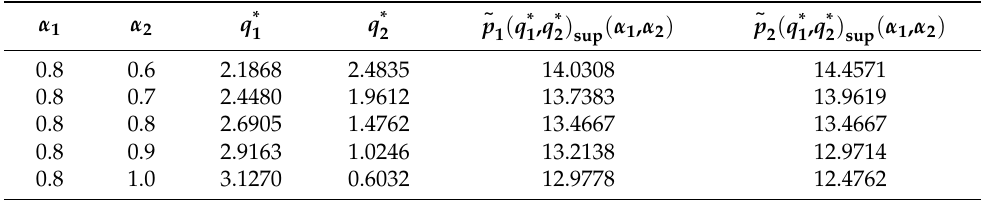
Table 11. ( α 1 , α 2 )-optimistic equilibrium quantity for Scenario IV when AG’s risk aversion levels